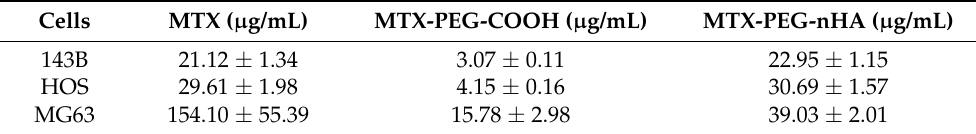
Table 1. The cytotoxicity of free MTX, MTX-PEG-COOH, and MTX-PEG-nHA on three kinds of osteosarcoma cells, as determined by the IC50